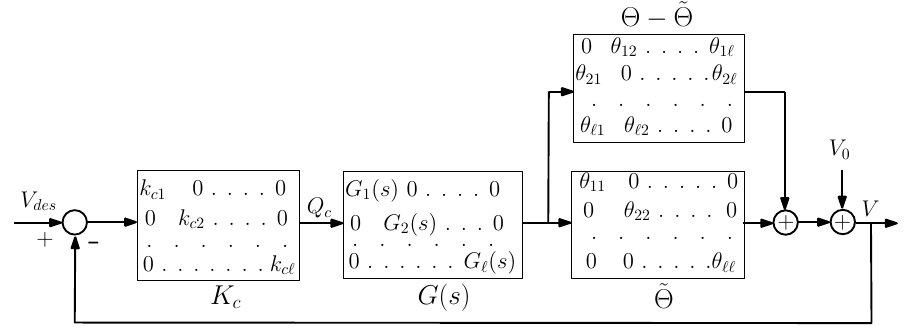
Figure 3. Block diagram representation of the interactions as additive